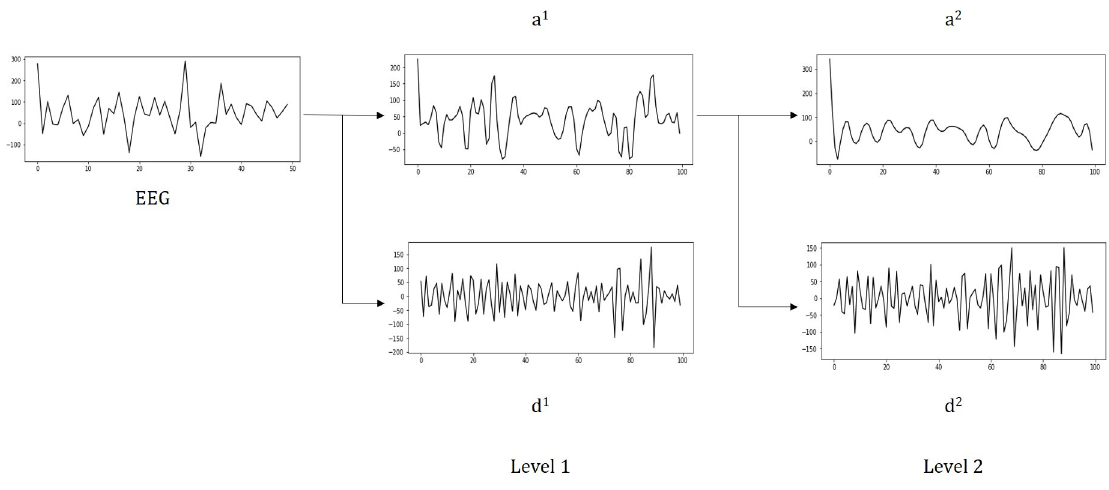
Figure 3. Example of two-level wavelet